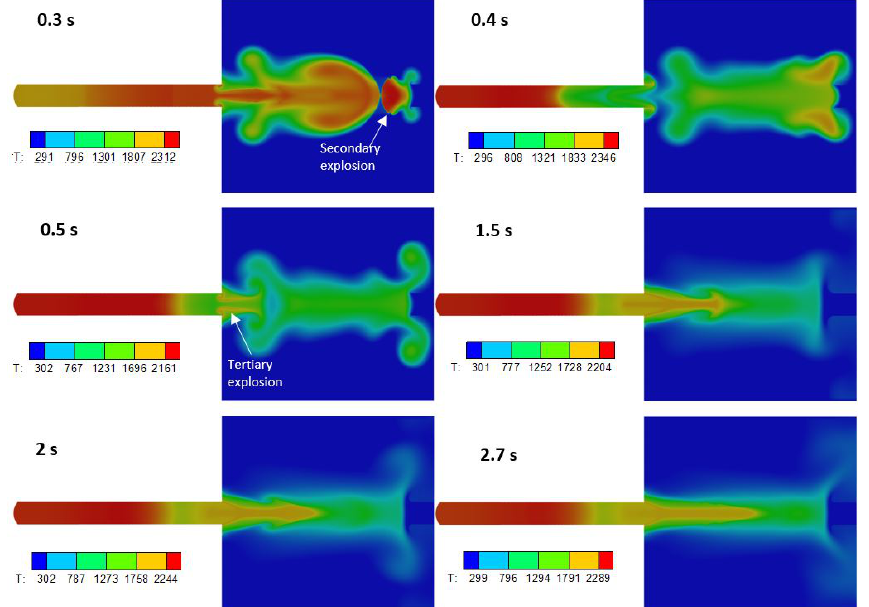
Figure 7. Time series of contour of temperature for the scenario where an explosion occurs in the RTO with 9.5% methane and generates flame that propagates out towards the